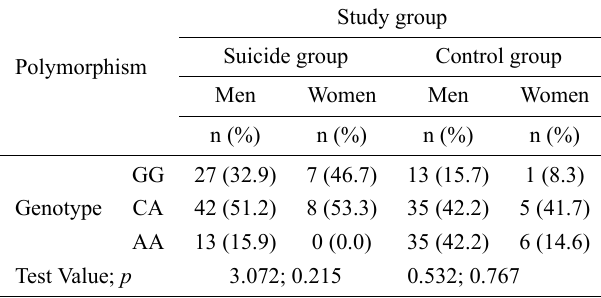
Table 7. Comparison of sex and presence of TPH-2 gene rs7305115 polymorphism in suicide cases.